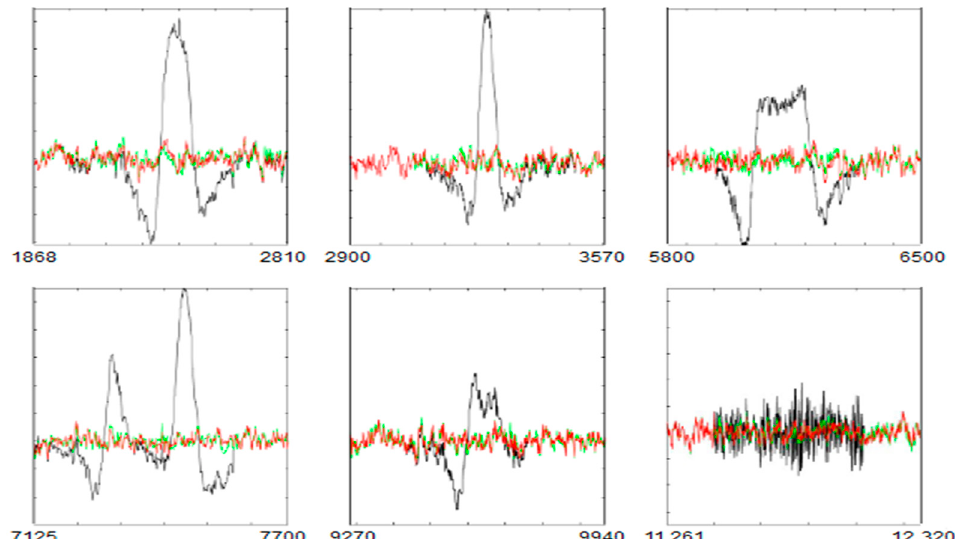
Figure 18. Some portions of SEEG with artefacts of the AF8 channel (in black), the corresponding REEG portions (in green) and the result of the filtering after using UAR (in red).